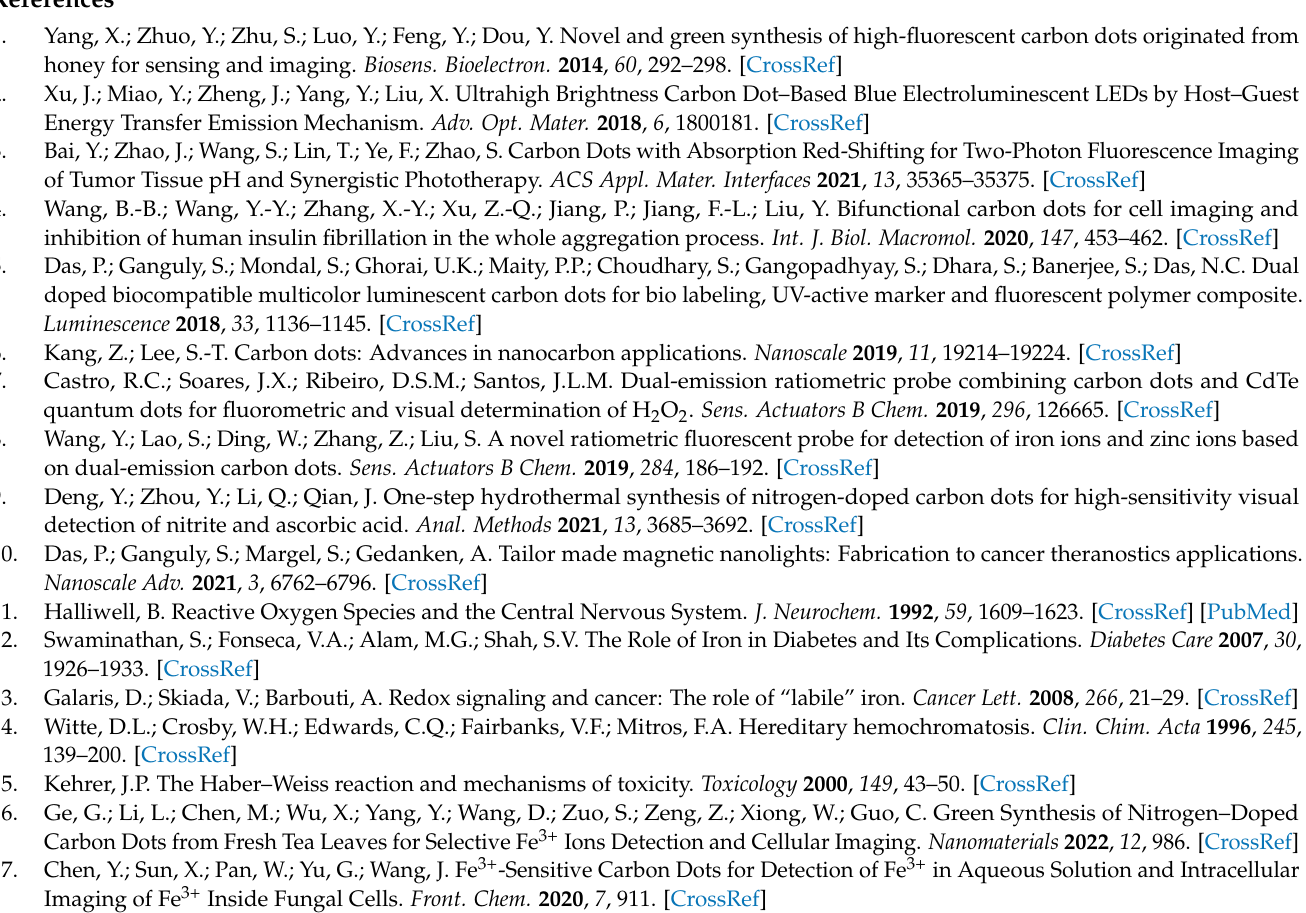
(b) different light time, (c) dif-ferent pH and (d) different reaction time at 1mM Fe 3+ concentration; Figure S3: Absorption spectra of Fe 3+ (blue line), NFCDs (red line), and NFCDs quenched by Fe 3+ (black line); Table S1: Fe 3+ detection ability of different fluorescent CDs. References [26–30] are cited in the Supplementary